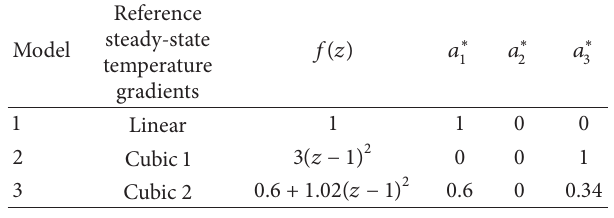
Table 1: Reference steady-state temperature gradients.